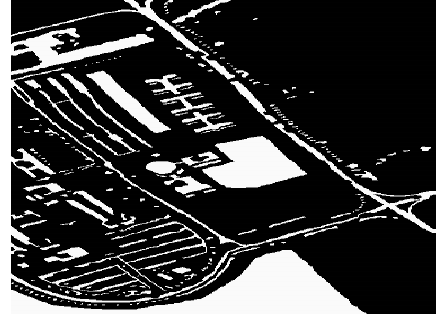
Figure 11. Grayscale image of Pavia University.